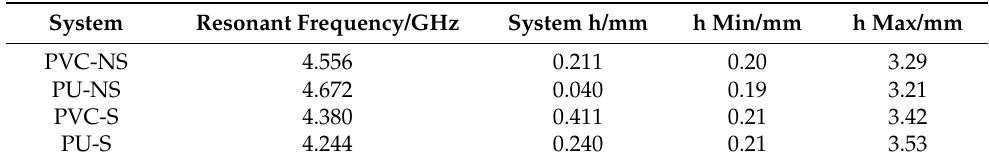
Table 4. Calculated optimum range of dielectric